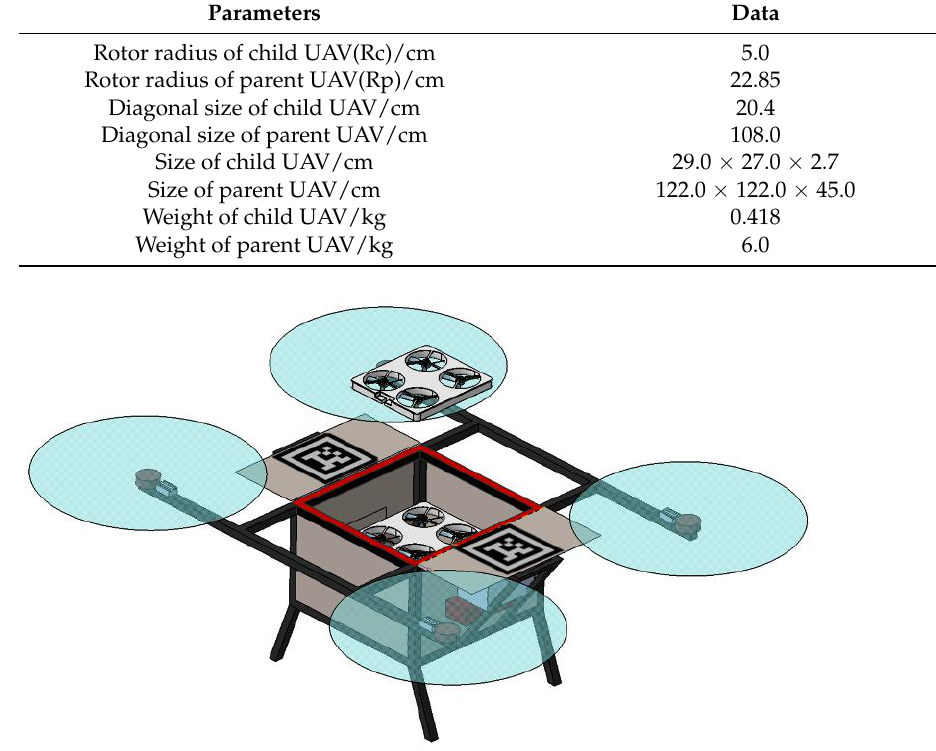
Figure 1. Schematic diagram of the launch and recovery process of the marsupial UAS. Table 1. Marsupial UAS